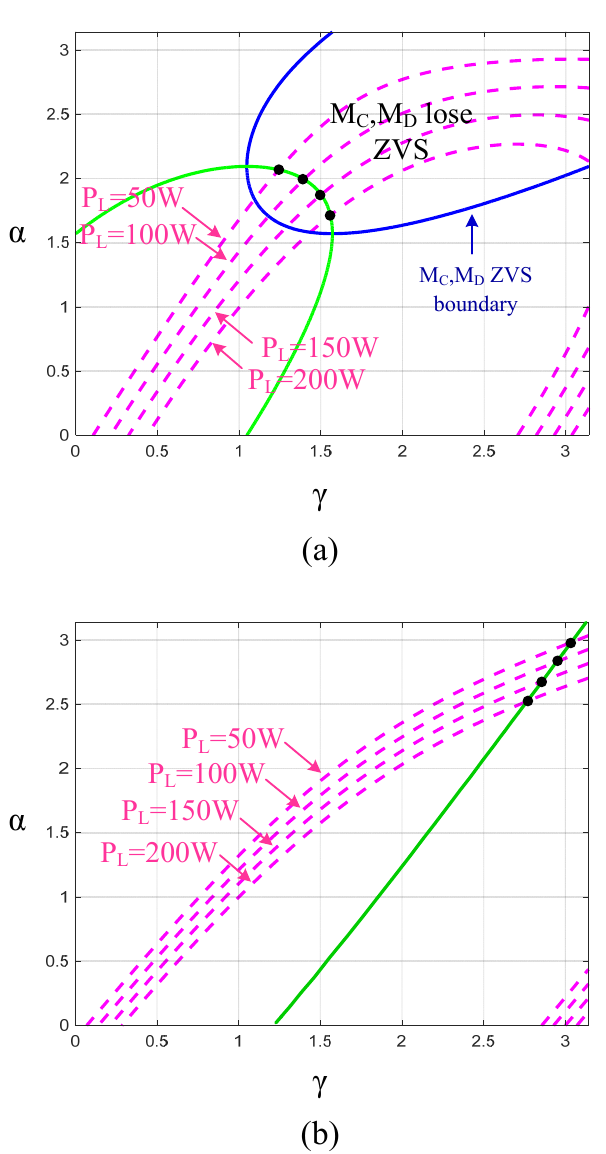
Figure 9. The ZVS region and the power lines of α and γ at M = 0.5: ( a ) k = 1; ( b ) k = 0.5. The voltages v xz and v yz have a phase shift α , and their amplitudes are V H /2 = 150